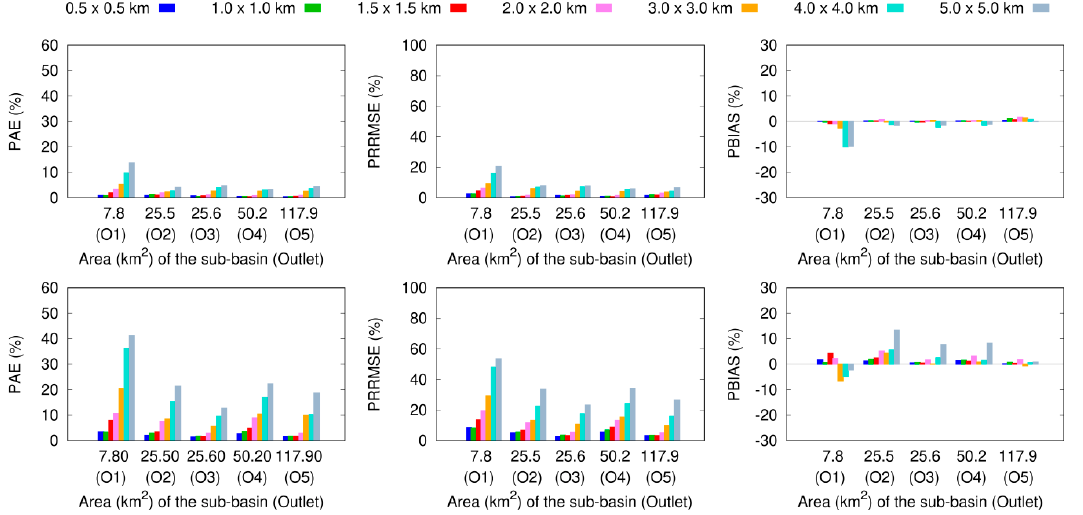
the simulated discharge over the sub-basin and outlet of the Tsurumi River Basin using different spatial